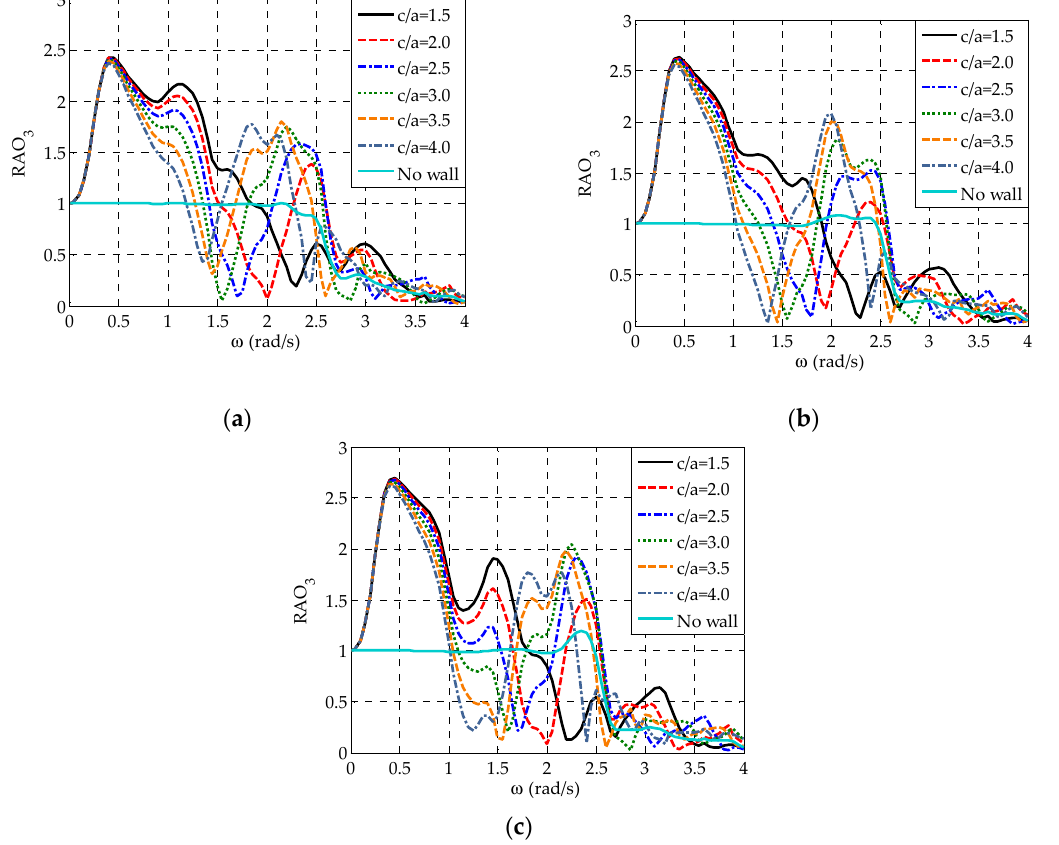
Figure 8. E ff ect of c / a on RAO 3 of the semi-immersed oblate spheroidal WECs for l w / a = 36 and Figure 8. Effect of 𝑐/𝑎 on 𝑅𝐴𝑂 (cid:2871) of the semi-immersed oblate spheroidal WECs for 𝑙 (cid:3050) /𝑎 = 36 and l bet / a = 4: ( a ) WEC1 and WEC5, ( b ) WEC2 and WEC4, and ( c ) 𝑙 (cid:3029)(cid:3032)(cid:3047) /𝑎 = 4 : ( a ) WEC1 and WEC5, ( b ) WEC2 and WEC4, and ( c ) WEC3.